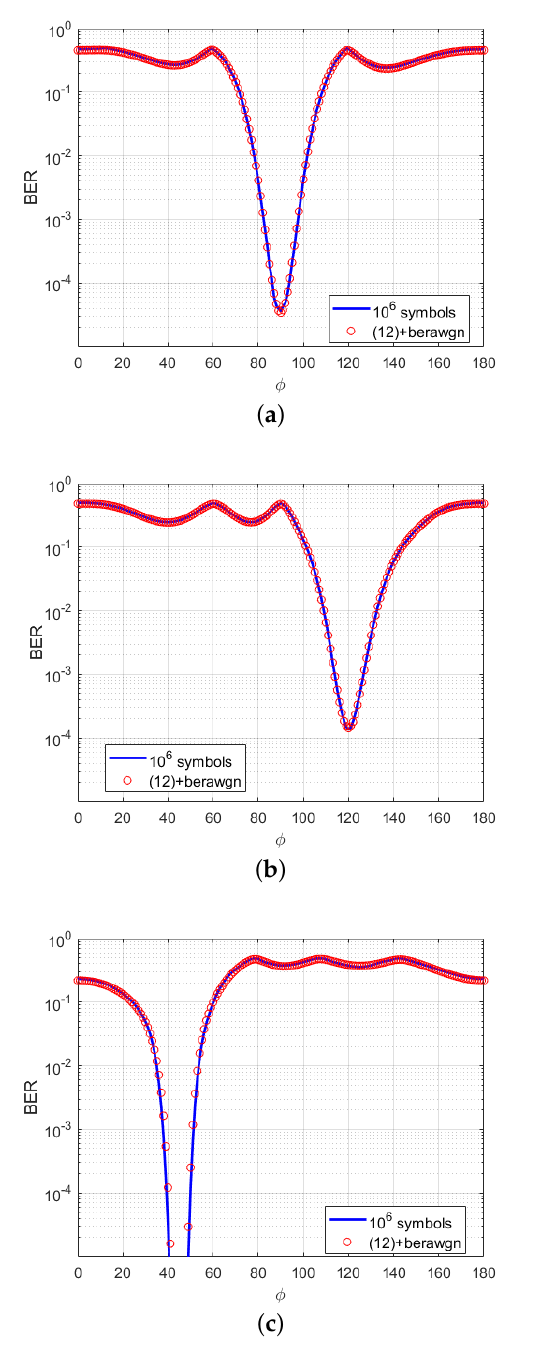
Figure 3. Array of four omnidirectional antennas along x-axis, spacing λ /2. BER in XY plane for DDM ( P = 64). Zero mean artificial Gaussian noise. Only half-plane is plotted due to symmetry. ( a ) QPSK modulation, φ 0 = 90 ◦ , signal-to-noise ratio (SNR)( φ 0 ) = 12 dB, PE DDM = 75%. ( b ) 16- QAM modulation, φ 0 = 120 ◦ , SNR( φ 0 ) = 18 dB, PE DDM = 90%. ( c ) 8-PSK modulation, φ 0 = 45 ◦ , SNR( φ 0 ) = 21 dB, PE DDM =